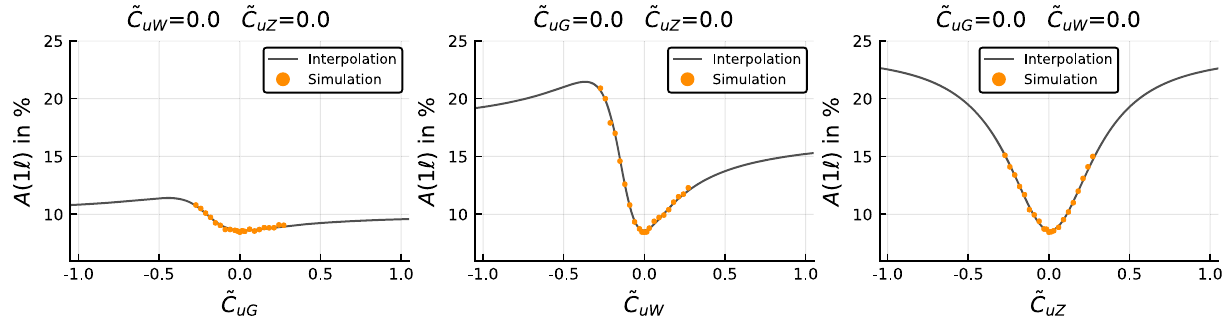
Fig. 5 Sampling points and interpolation result for the fiducial acceptance of the single-lepton channel A ( 1 (cid:14)) , represented as slices of the phase space where only one of the Wilson coefficient is varied at a time, while the others are set to